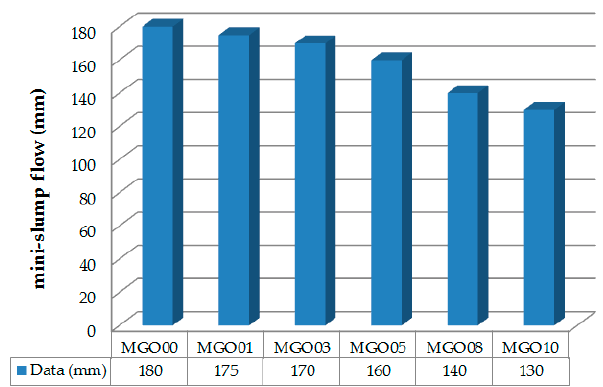
Figure 4. Effect of GONSs contents on the fluidity of cement mortars. The mortar samples containing 0.00%, 0.01%, 0.03%, 0.05%, 0.08%, and 0.10% by weight of cement (bwoc) GONSs are numbered as MGO00, MGO01, MGO03, MGO05, MGO08, and MGO10, respectively.